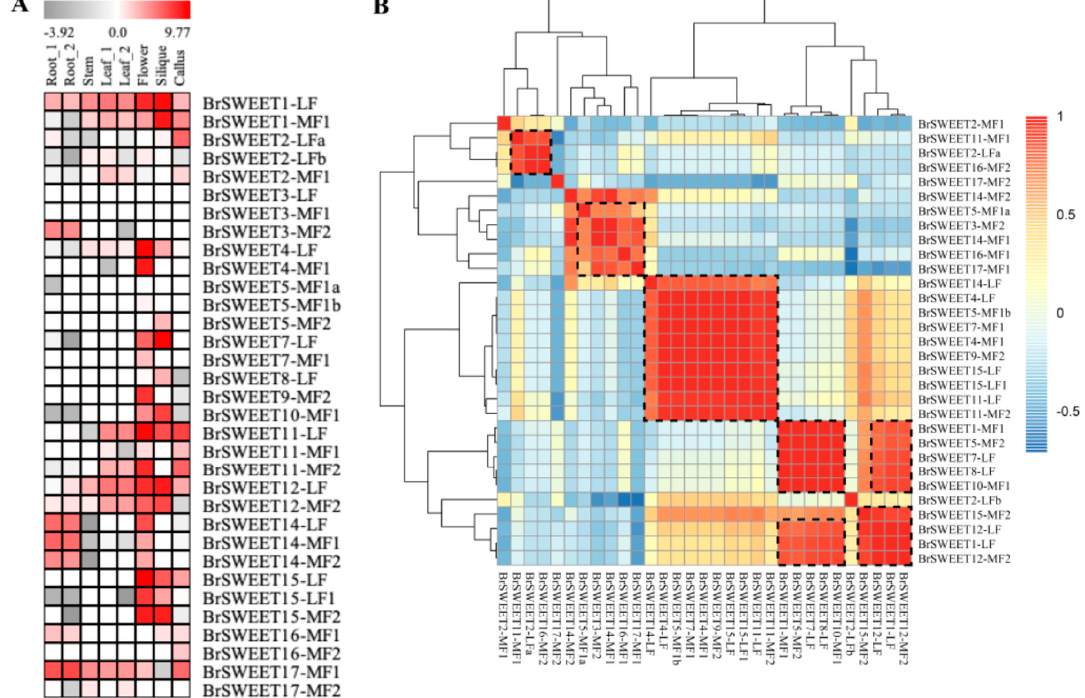
Figure 4. Heat map ( A ) and Pearson correlation coefficient (PCC) analysis ( B ) of the SWEET gene transcriptional levels in different tissues of Brassica rapa . The dotted black box indicates the members with transcriptional correlation. Blocks with colors ( A ) indicate low (dark) to high (red) normalized transcript accumulation and blocks, with colors in ( B ) indicating a negative PCC correlation ( − 1) to positive PCC correlation (1).